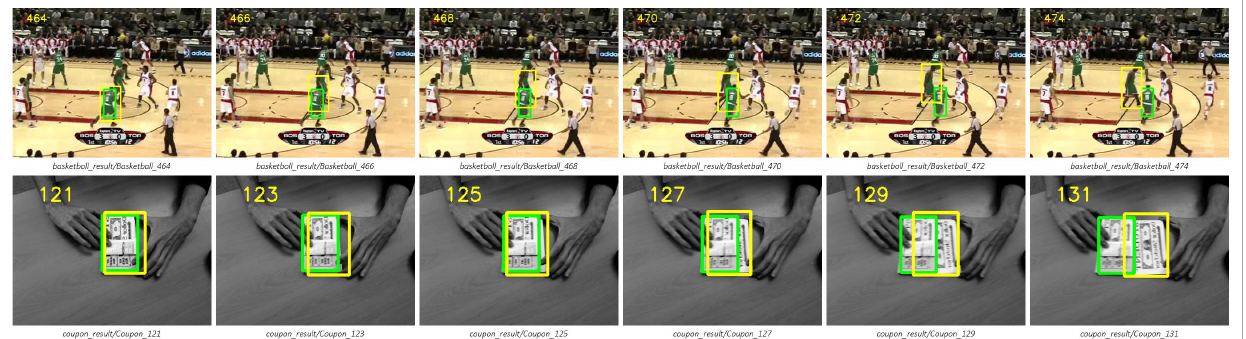
Figure 1. Drift problem leads to wrong target, when there is similar object interference in complex scenes. Green box is ground true and yellow box is the result of a Siamese-based